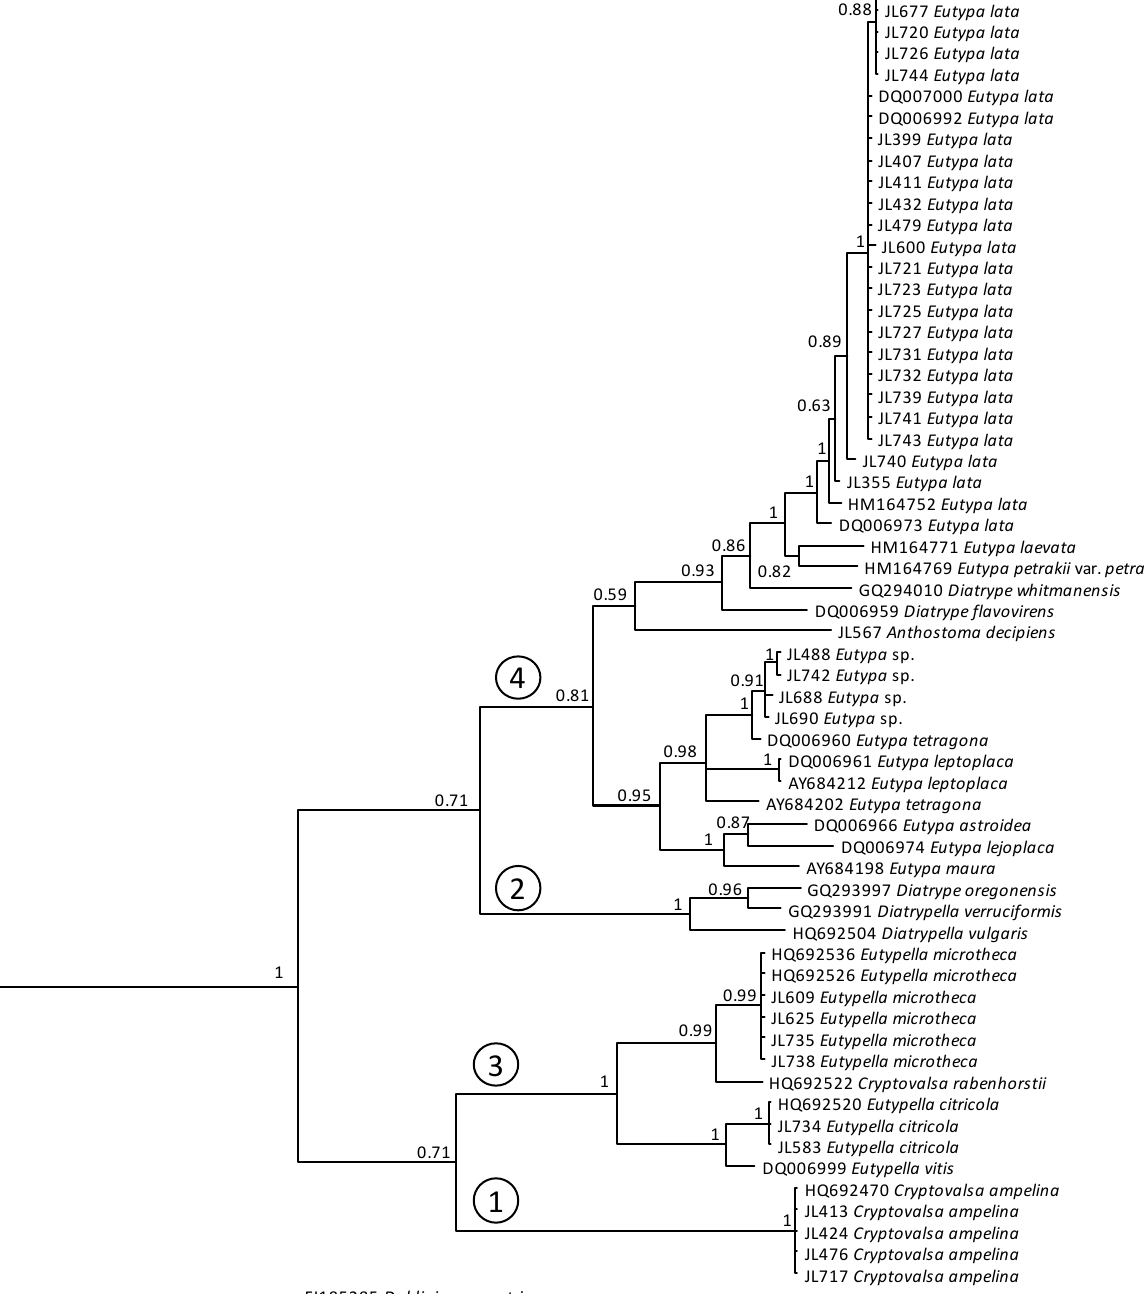
Figure 2. Majority rule consensus tree resulting from the Bayesian analysis of the β-tubulin sequence data, with posterior probabilities reported at the nodes. Sequences obtained from GenBank are indicated by their accession numbers while iso- lates obtained in this study are indicated by their code numbers. Clades are numbered in circles. Bars represents expected changes per